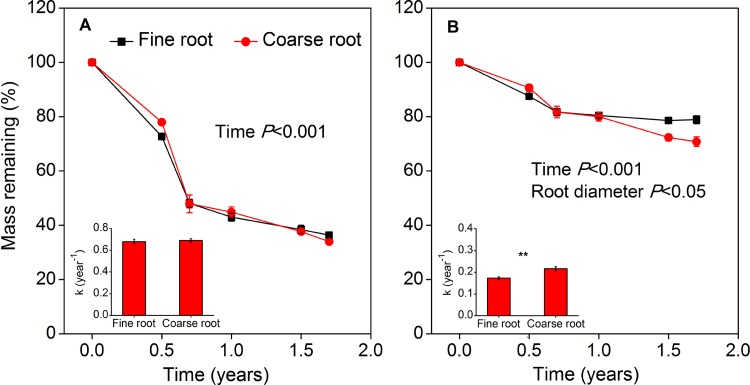
Residual mass for two diameter size classes of E. oxyrrhynchum (A) and S. santolinum (B) roots decomposing in the field over a period of 1.7 years (experiment II).Water and N addition treatments have been averaged by root size class within each species. ** indicate significant differences between fine and coarse roots within each species (P<0.01). Vertical bars represent standard errors (n = 12). Insets show decomposition rates for fine and coarse roots of E. oxyrrhynchum and S. santolinum, respectively.